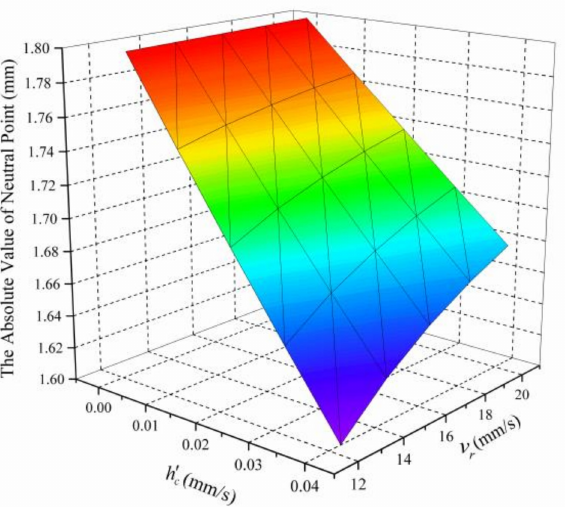
Figure 15. The influence of roll gap reduction velocity and rolling velocity on the position of neutral point (2 h 1 = 1.57